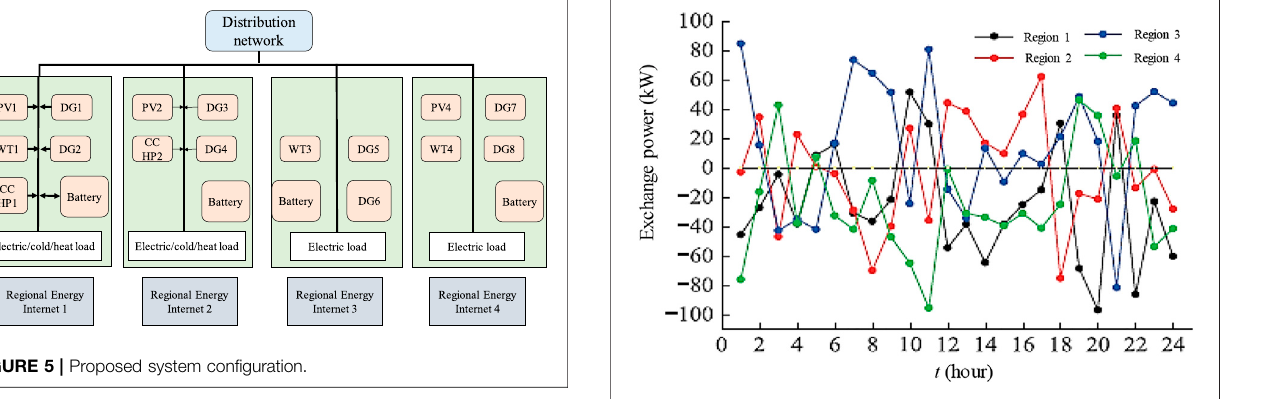
FIGURE 7 | Comparison of exchange power between each region.